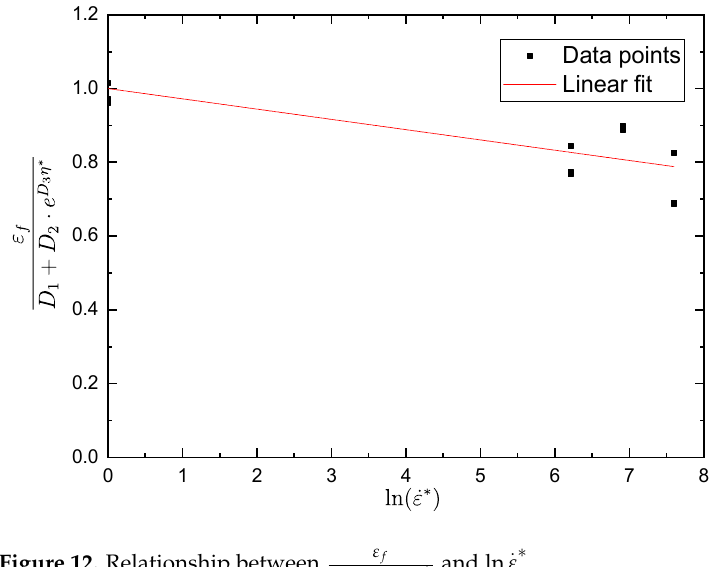
Figure 12. Relationship between ε f